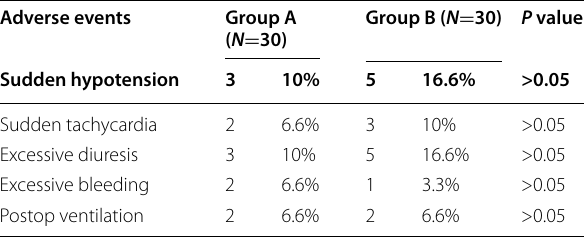
Table 6 Comparison of patients according to adverse